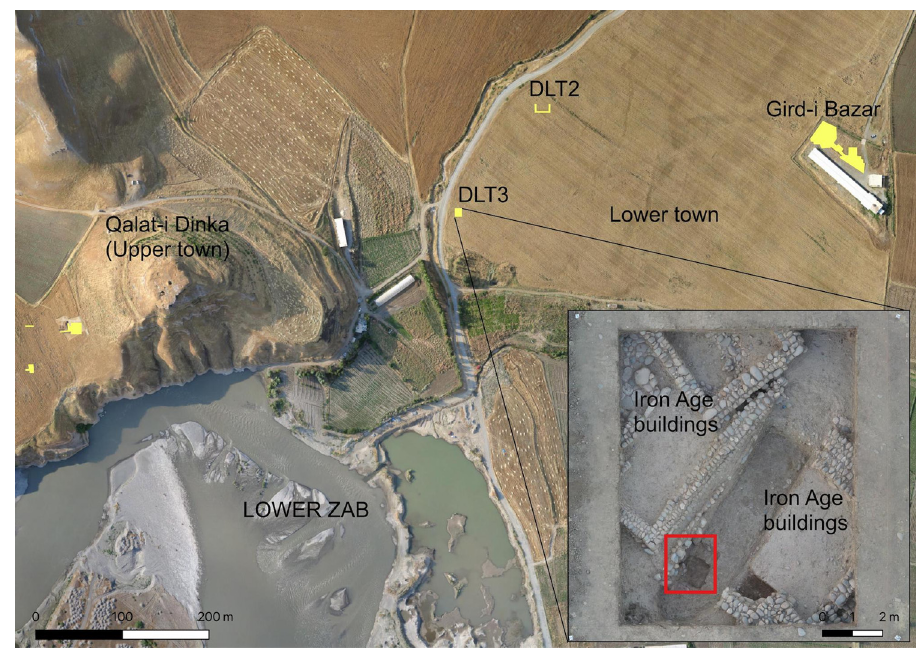
Figure 2: Orthophoto of the Dinka Settlement Complex, with in yellow the excavated areas updated to 2019. The inset shows the operation DLT3, where the Chalcolithic kiln was found ( red square ) below the Iron Age walls. Orthophoto by ICONEM ( courtesy of J. Giraud ) . Prepared by Andrea